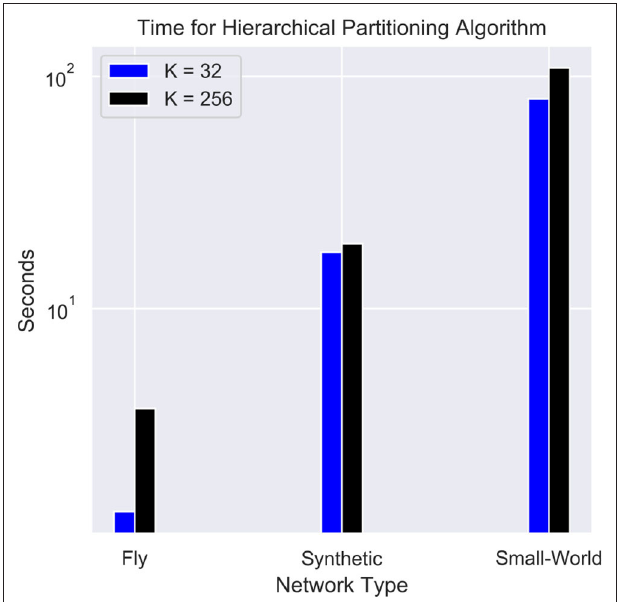
FIGURE 9 | Timing for the hierarchical partitioning of each network. The synthetic network used contains 256,000 neurons and 65,536,000 synapses, and the small-world network contains 1 million neurons and a fan-out of 256.